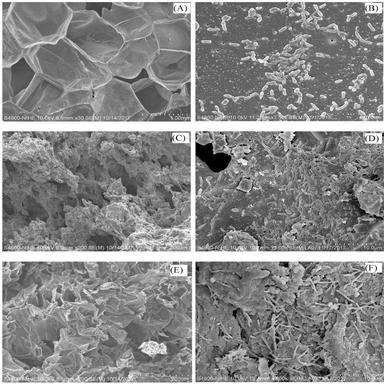
Scanning electronic microscope (SEM) micrographs of the biocarriers without the PPB bacteria strains (A: PUF; C: CB; E: CF) and with the consortium colonizing the surface of the biocarriers (B: PUF; D: CB; F: CF) after examination with PAHs.